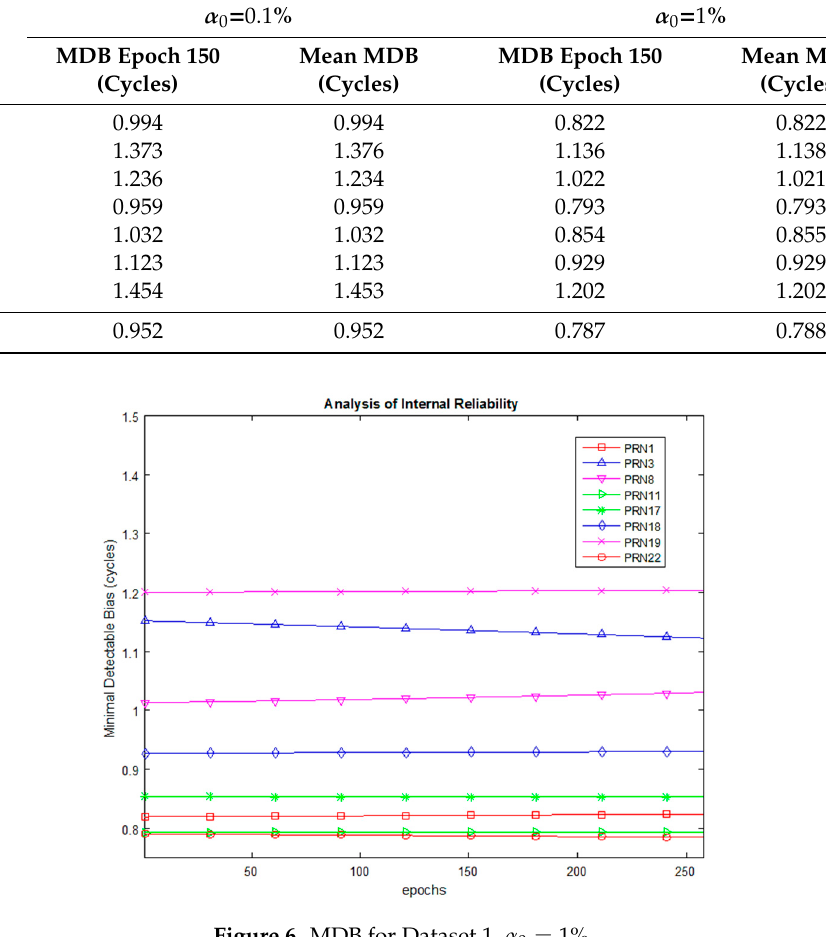
Table 4. Minimal detectable biases (MDBs) for observable satellites in Dataset 2.